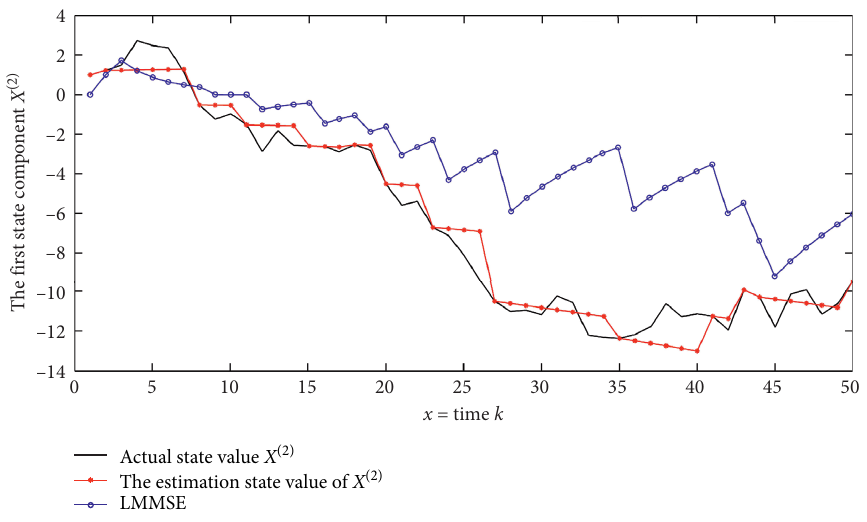
Figure 4: X ( 2 ) comparison between optimal estimation and LMMSE.